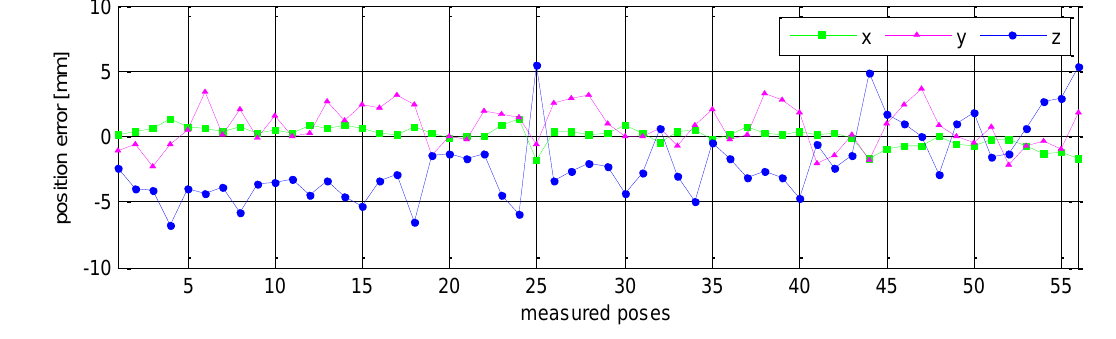
Figure 7. Robot position accuracy after calibration (pose set Q